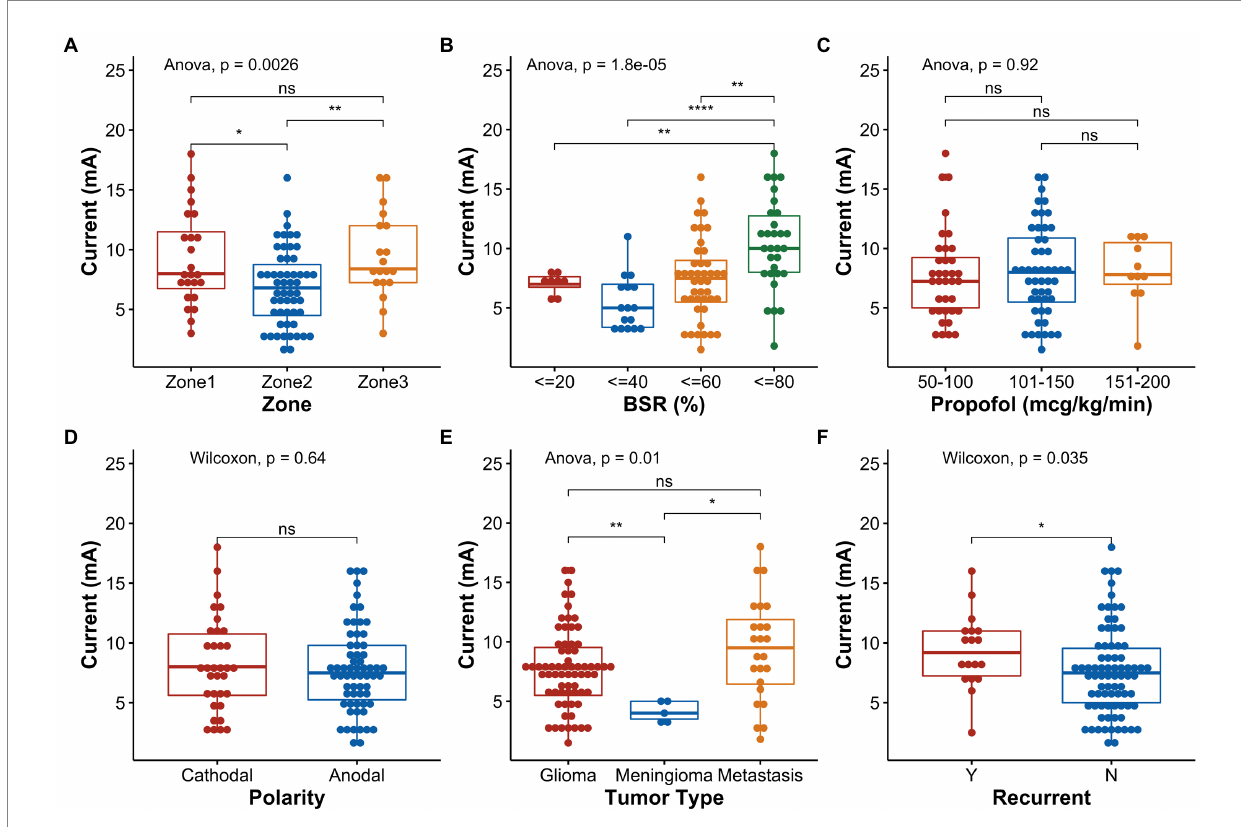
FIGURE 4 Boxplots and statistical comparisons of the normalized stimulation current thresholds for selected variables. (A) Stimulation zone, (B) burst suppression ratio (BSR), (C) propofol infusion rate, (D) stimulation polarity, (E) tumor type, and (F) tumor recurrence. Significance level: ns, not significant, * p < 0.05,